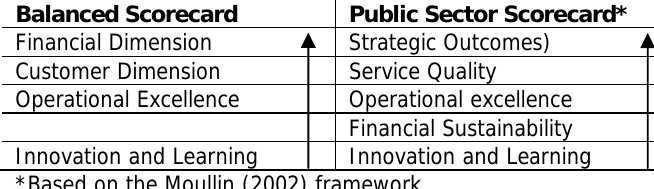
Figure 1: A proposed public research sector